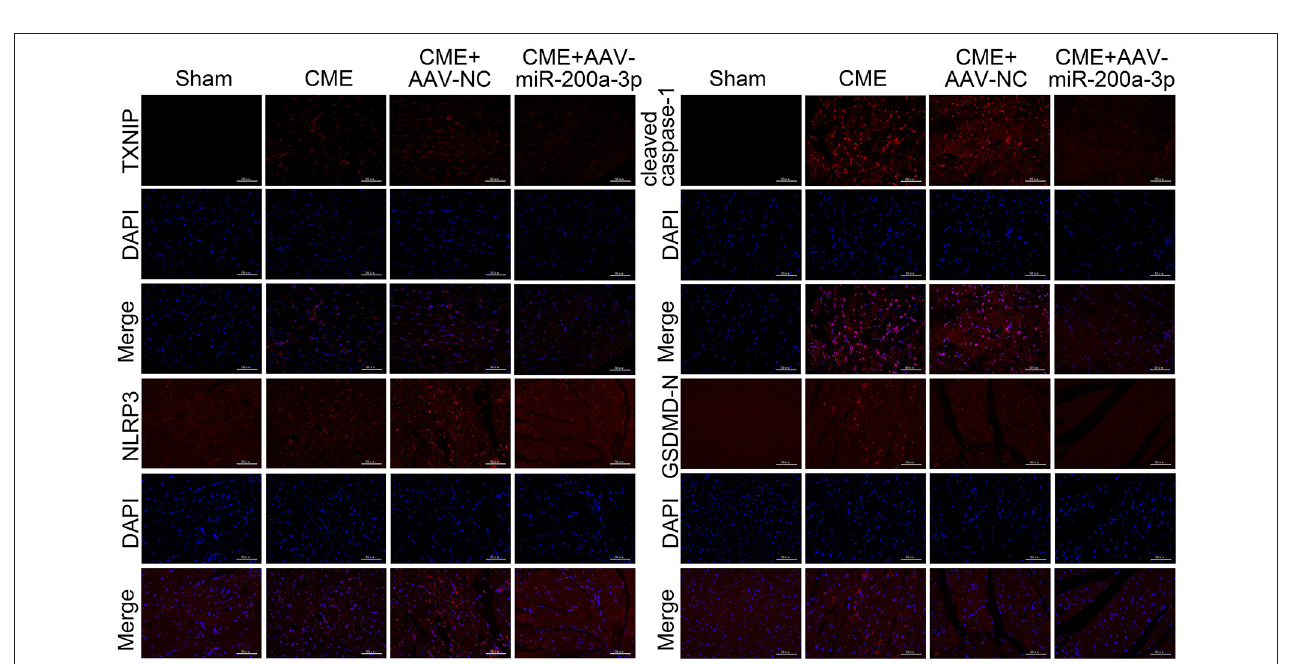
FIGURE 8 | Immunofluorescence staining of TXNIP, NLRP3, cleaved caspase-1, and GSDMD-N in myocardial tissues ( n = 3 per group). CME, coronary microembolization.